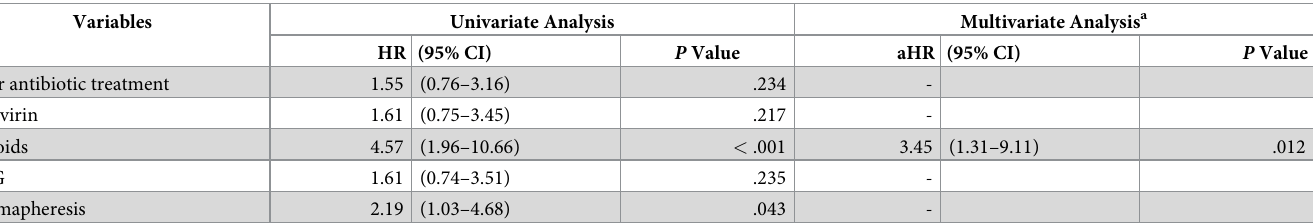
Table 5. Treatment Effects on 30-day Mortality in Patients with